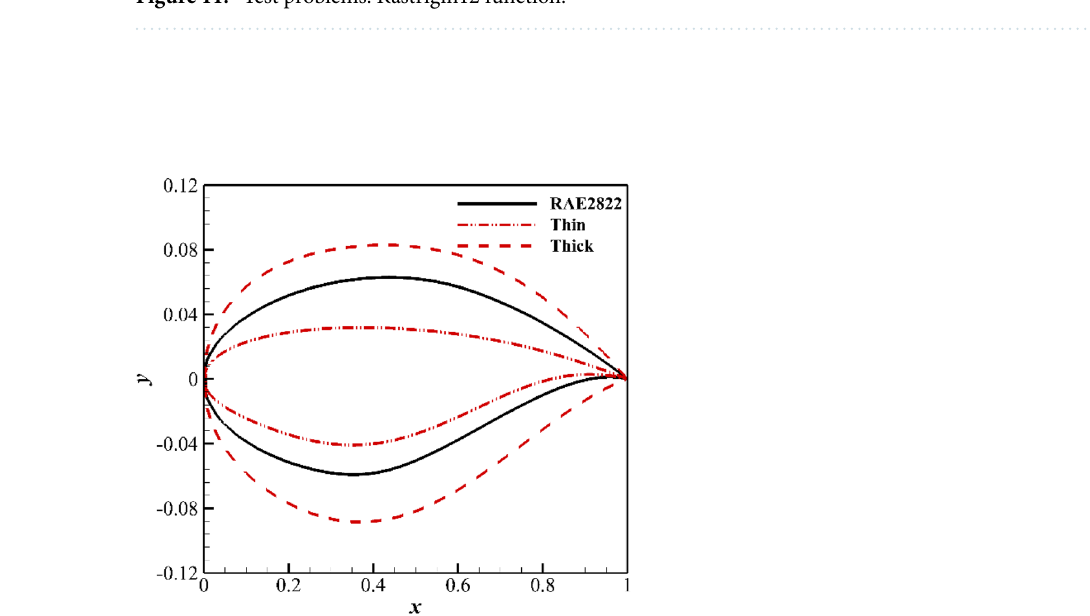
Figure 11. Test problems: Rastrigin12 function.